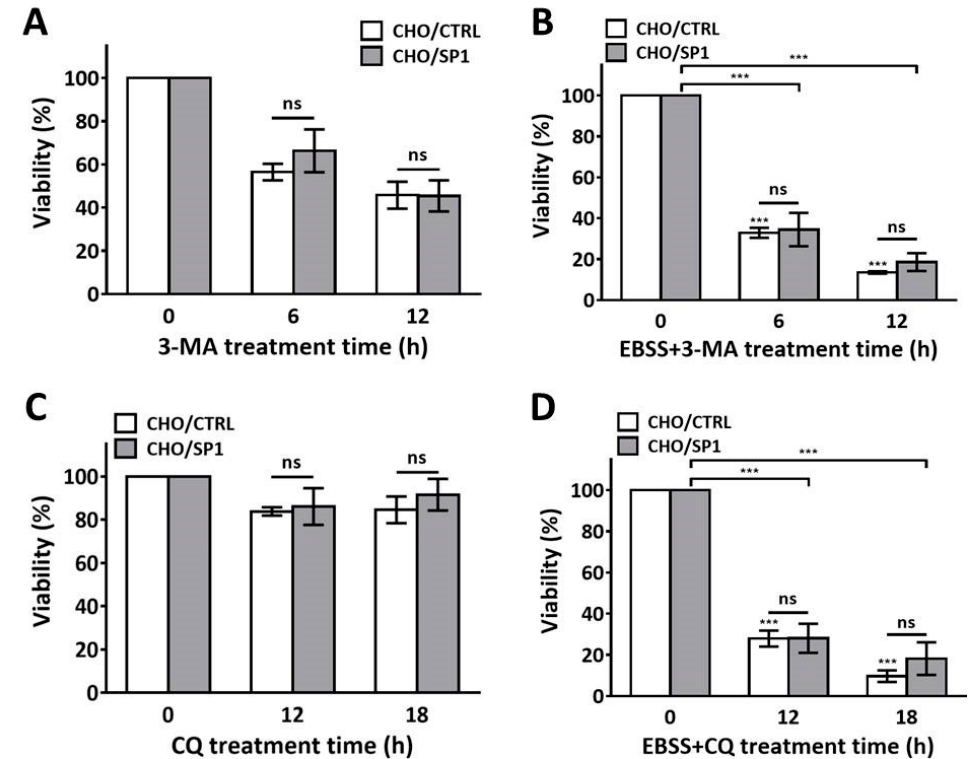
Figure 6. The effect of SP1 on cell viabilities in autophagy blockade. ( A , B ) The effect of SP1 on cell death in the CHO cells treated with 3-MA for 0, 6, and 12 h in the ( A ) absence or ( B ) presence of EBSS. ( C , D ) The effect of SP1 on cell death in the CHO cells treated with CQ for 0, 12, and 18 h in the ( C ) absence or ( D ) presence of EBSS. Cell viability was measured by performing the Trypan blue dye exclusion assay. All values are represented as mean ± SD (*** p < 0.001; n = 3).